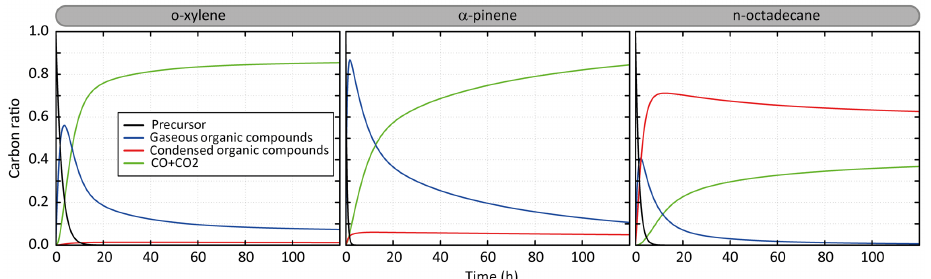
Figure 2. Temporal evolution of the simulated carbon distribution between the precursor, CO and CO 2 , and gaseous and condensed organic compounds. Simulated results are shown for o-xylene, α -pinene and n-octadecane for the scenario performed at a temperature of 298K, a zenith angle of 50 ◦ , a C oa of 1µgm − 3 , 40ppb of ozone and a RRR of